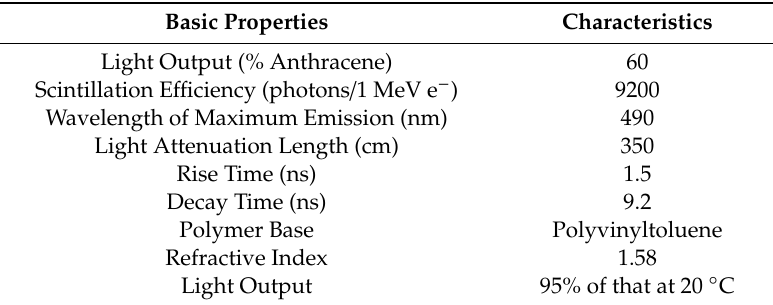
Table 4. Characteristics of the EJ-260 scintillator.